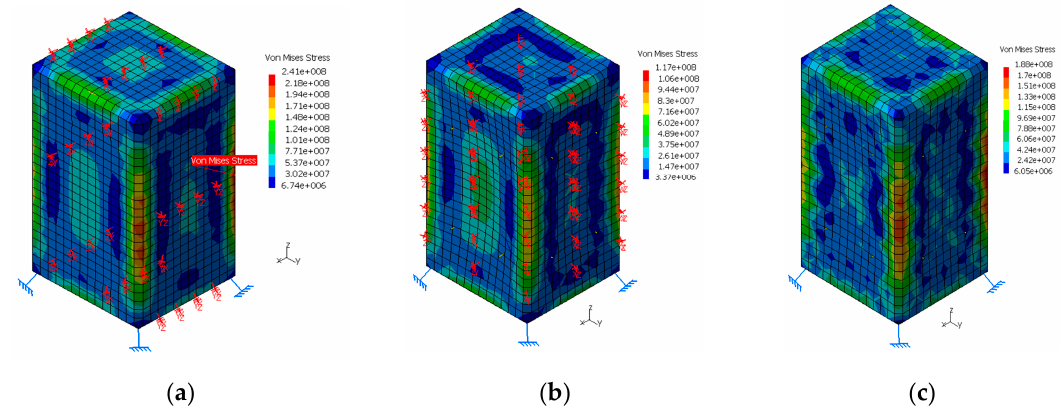
Figure 1. Specifications of the cross-section of the T-shaped beam. B : flange width, H: height of section, t 1: web width, t 2: slab thickness.